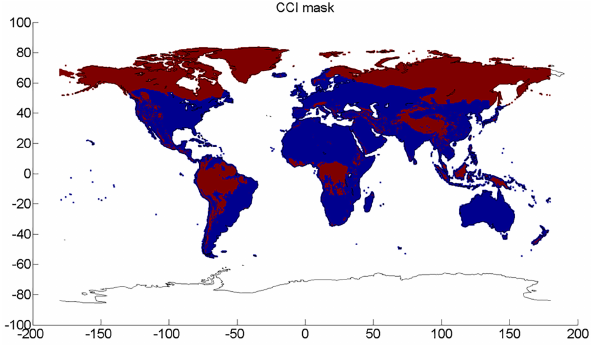
Figure 1. Data mask used for remove areas (red areas) character- ized by issues in the soil moisture